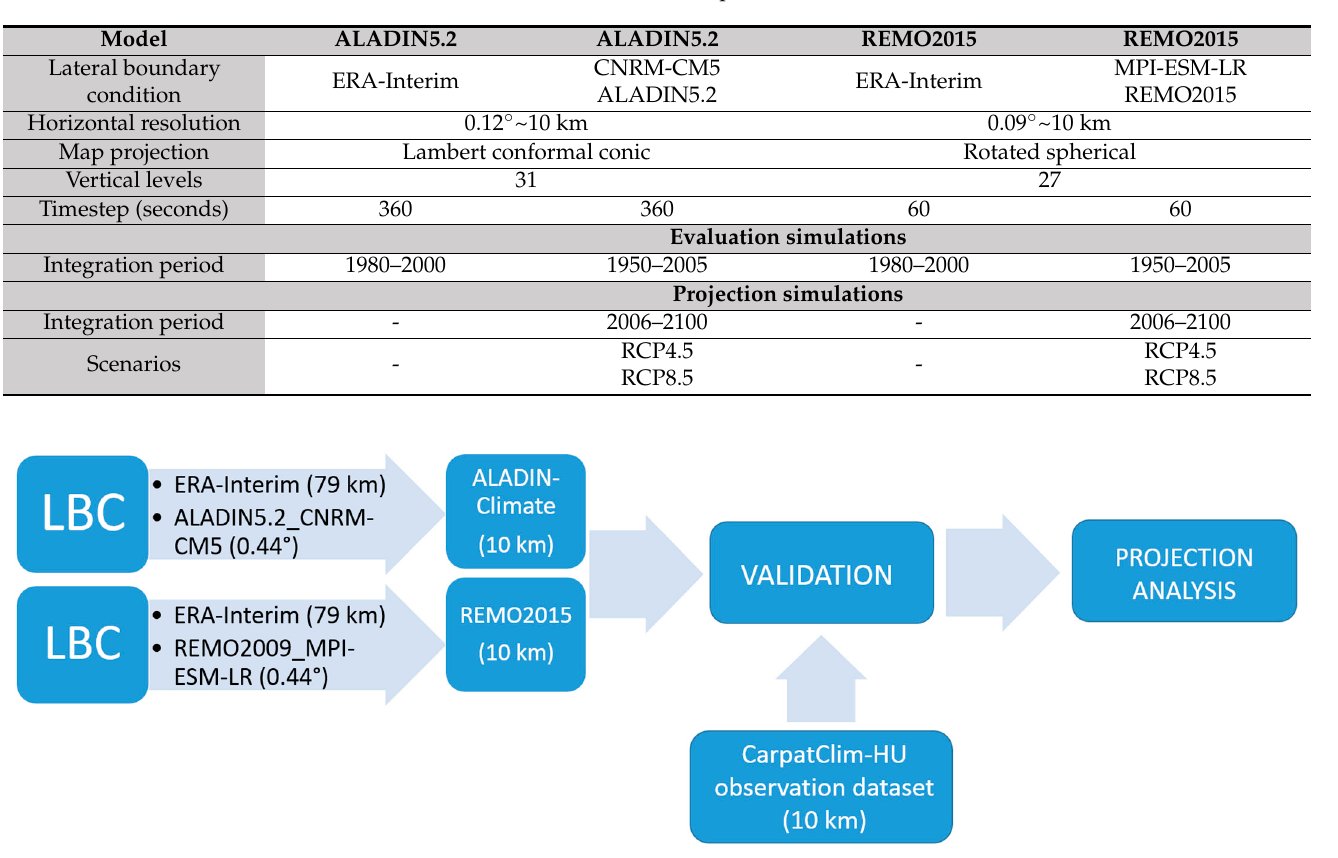
Figure 2. The flowchart of the research process.